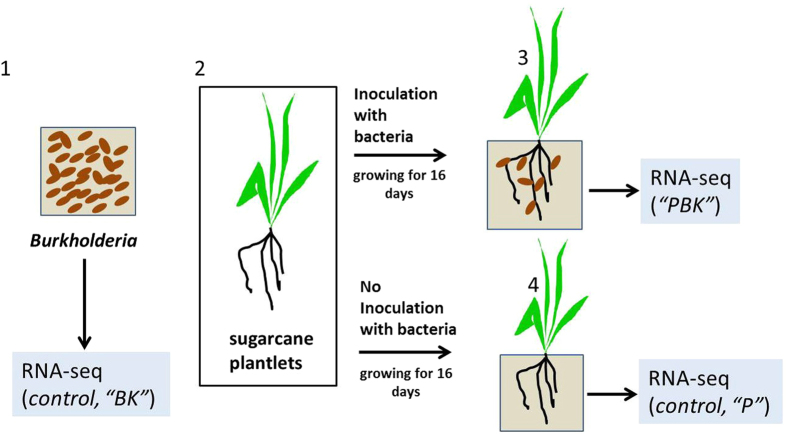
Schematic presentation of the “dual transcriptome analysis”.Sugarcane plantlets (2) were inoculated with Burkholderia Q208 culture (1) and plants were grown for 16 days (3). The control, non-inoculated plants (4) were also grown for 16 days. Subsequently, bacterial culture (1), roots of the control plants (4; boxed area), and roots of the inoculated plants (3, boxed area) were subjected to transcriptomic analyses. In the case of (3) the analyses included the transcriptomes of both bacteria and plant roots (“dual transcriptomics”).